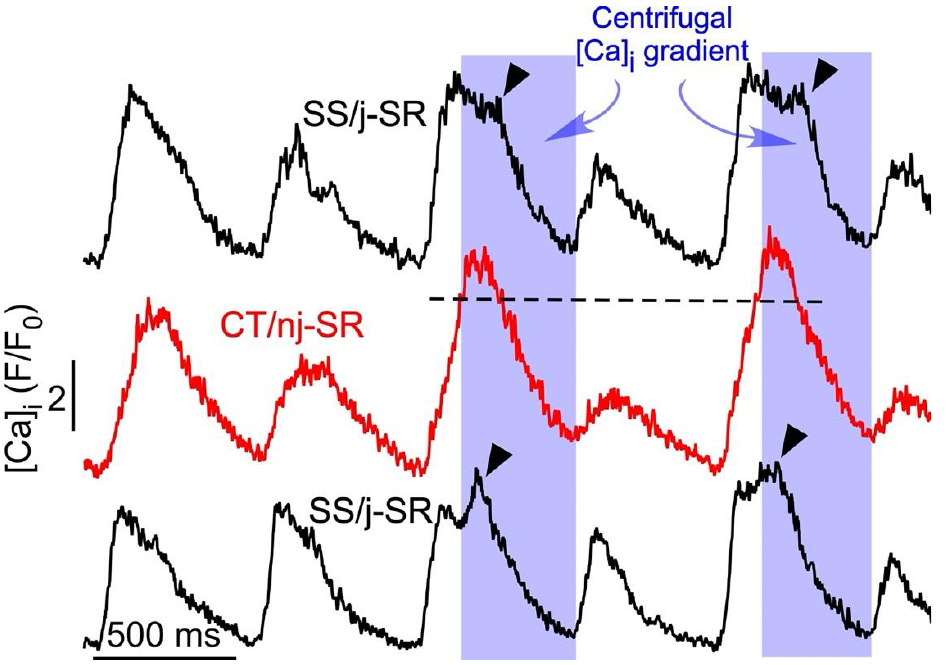
Figure 2. Secondary SR Ca release during atrial CaT alternans. Subcellular CaT traces recorded from 1 µm wide regions by confocal transverse line scan imaging from the cell center (CT/nj-SR; red trace) and opposite subsarcolemmal regions (SS/j-SR; black traces). Alternans was induced by electrical pacing at 1.8 Hz. Reversal of the subcellular [Ca] i gradient from centripetal to centrifugal (shaded) during the later phase of the CaT elicits secondary SS j-SR Ca release (arrow head), leading to a prolongation of the SS CaT and enhanced refractoriness of j-SR Ca release during the subsequent beat. Dashed line indicates peak SS CaT.